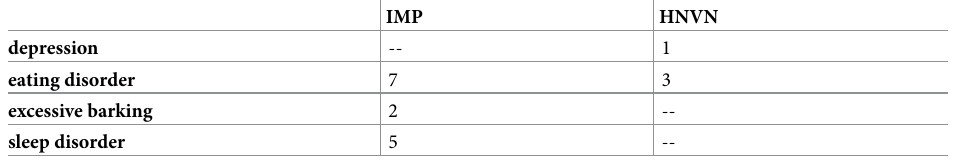
Table 8. Raw numbers of IMP and HNVN dogs for each “other” (non-listed) behavioural trouble as manually reported by owners. IMP HNVN depression -- 1 eating disorder 7 3 excessive barking 2 -- sleep disorder 5 -- Troubles are sorted in alphabetic order. The “--” symbol means that no dog was